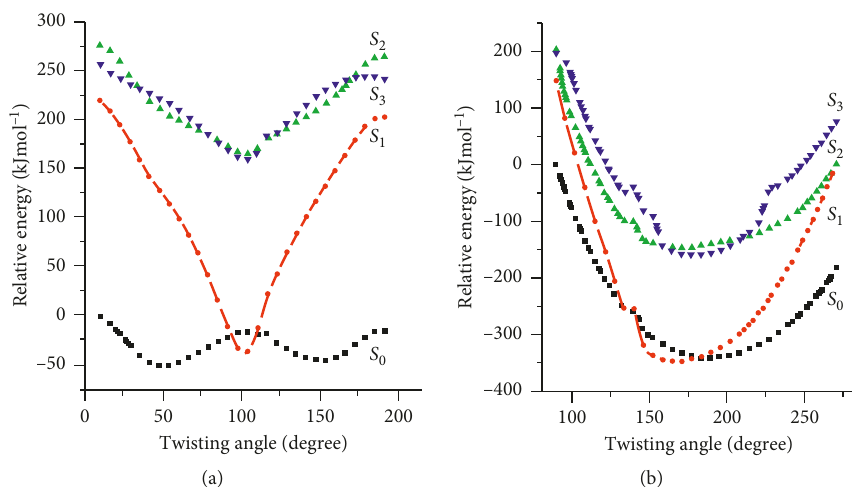
Figure 11: 2D PES due to single (S1-bond) twisting (a) and double (C9-C19 bond) twisting angles (b). ORCA: BP86 D3 RIJCOSX DEF2- SVP DEF2/JK TIGHTSCF. Orca computation results are graphically represented using Spartan’16